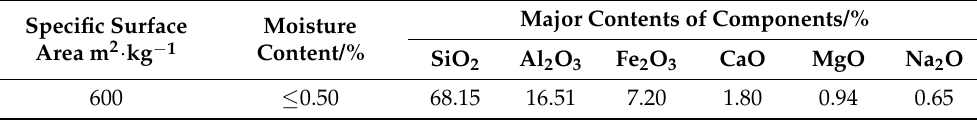
Table 4. Main indexes and components of recycled brick powder.